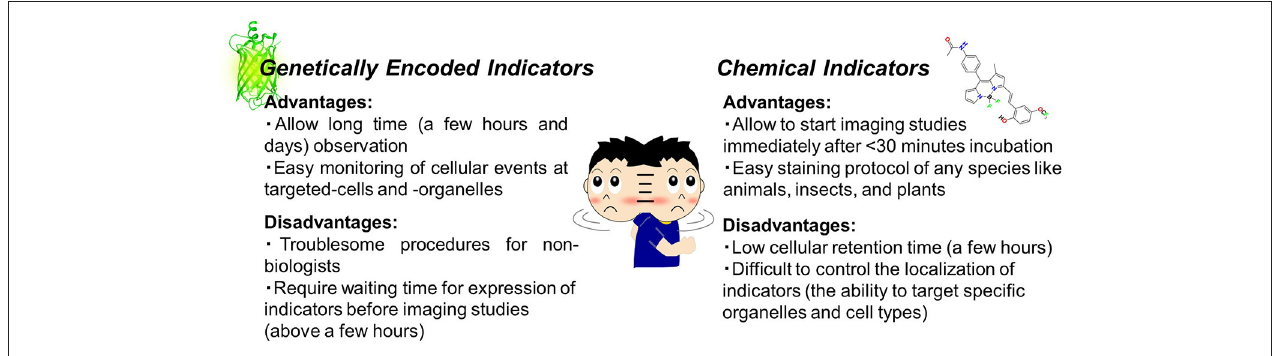
FIGURE 1 | Chemical indicators vs. genetically encoded indicators (PDB ID: